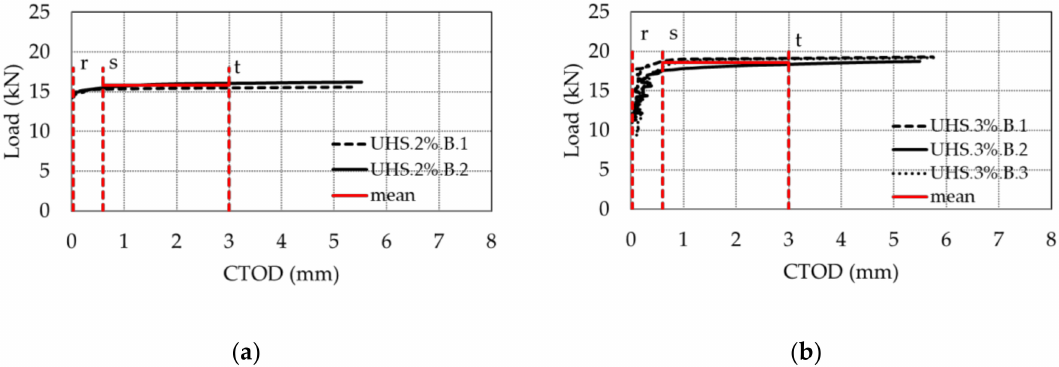
Figure 4. Load-crack tip opening displacement (CTOD) curves for the notched UHS beams with ( a ) 2% and ( b ) 3% volumetric fraction of steel fiber. The incorrect test for one beam with 2% fiber fraction is not reported. Table 2. Bending test on the concrete reinforced with steel fibers (UHS): CNR DT 204/2006